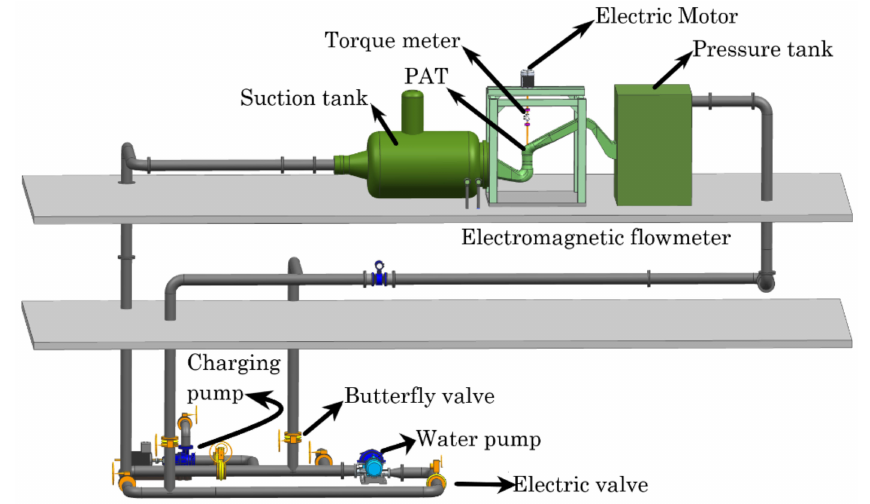
Figure 3. Schematic diagram of the PAT testing